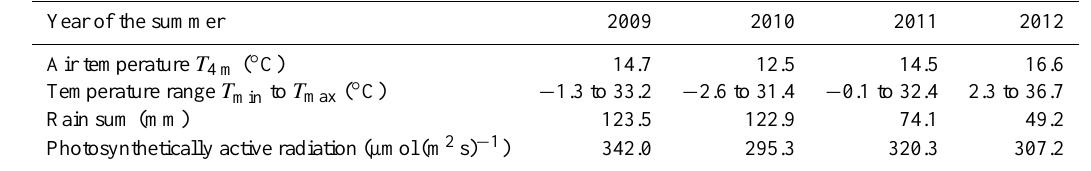
Table 1. Yearly averaged climatic conditions at ZOTTO during the summer months June–September.